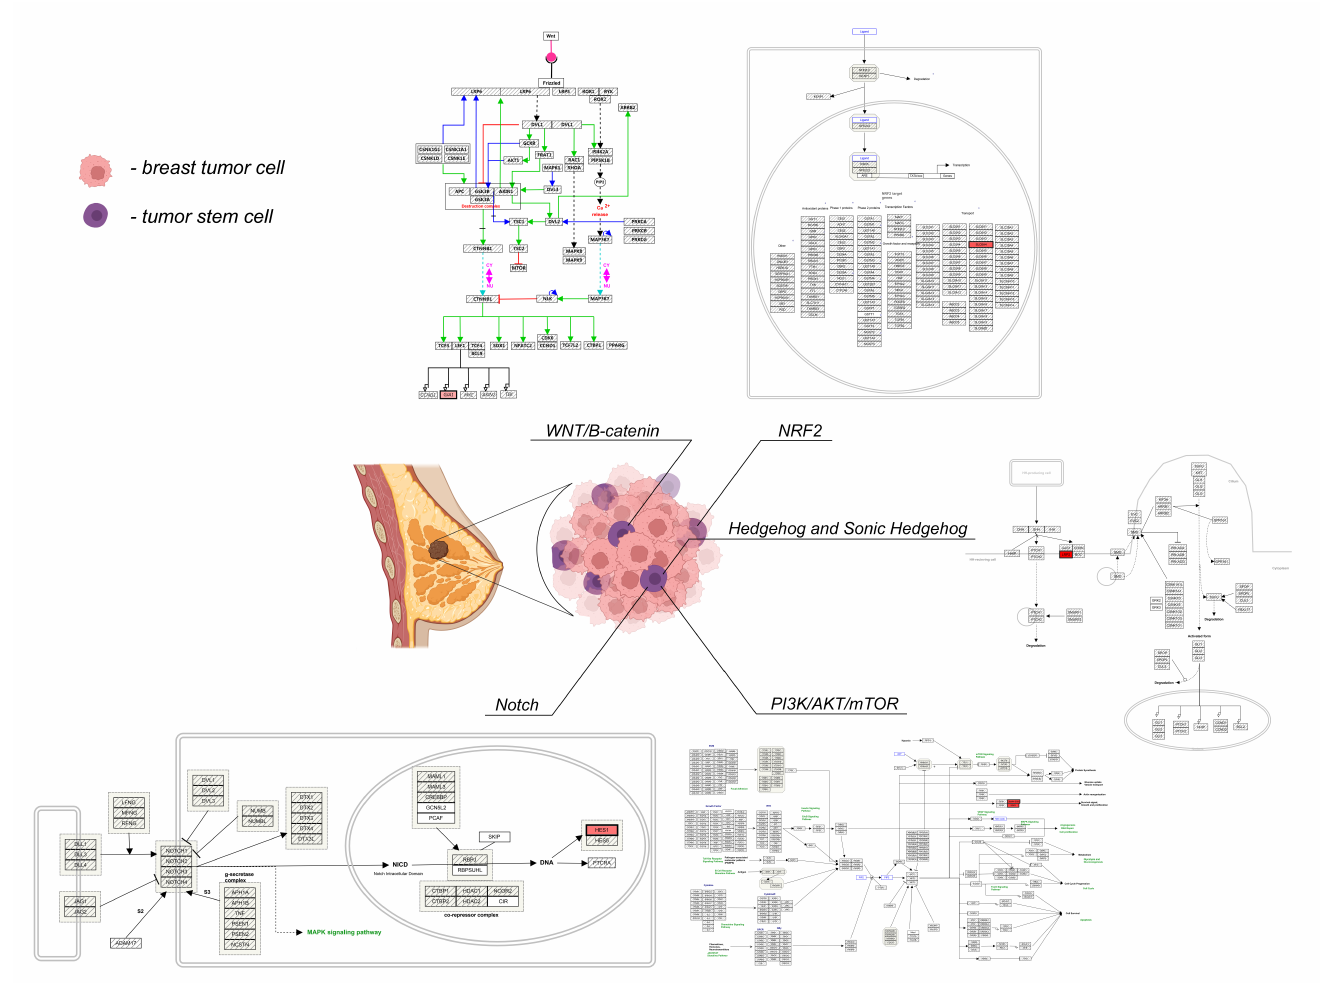
Figure 1. The signalling pathways of CSCs in breast cancer. Note: Created with Biorender.com. Wnt signaling pathway (Homo sapiens). https://www.wikipathways.org/index.php/Pathway:WP363 (accessed on 1 March 2022). Notch signaling (Homo sapiens). https://www.wikipathways.org/index. php/Pathway:WP268 (accessed on 1 March 2022). NRF2 pathway (Homo sapiens). https://www. wikipathways.org/index.php/Pathway:WP2884 (accessed on 1 March 2022). Hedgehog signaling pathway (Homo sapiens). https://www.wikipathways.org/index.php/Pathway:WP4249 (accessed on 1 March 2022). PI3K-Akt signaling pathway (Homo sapiens).